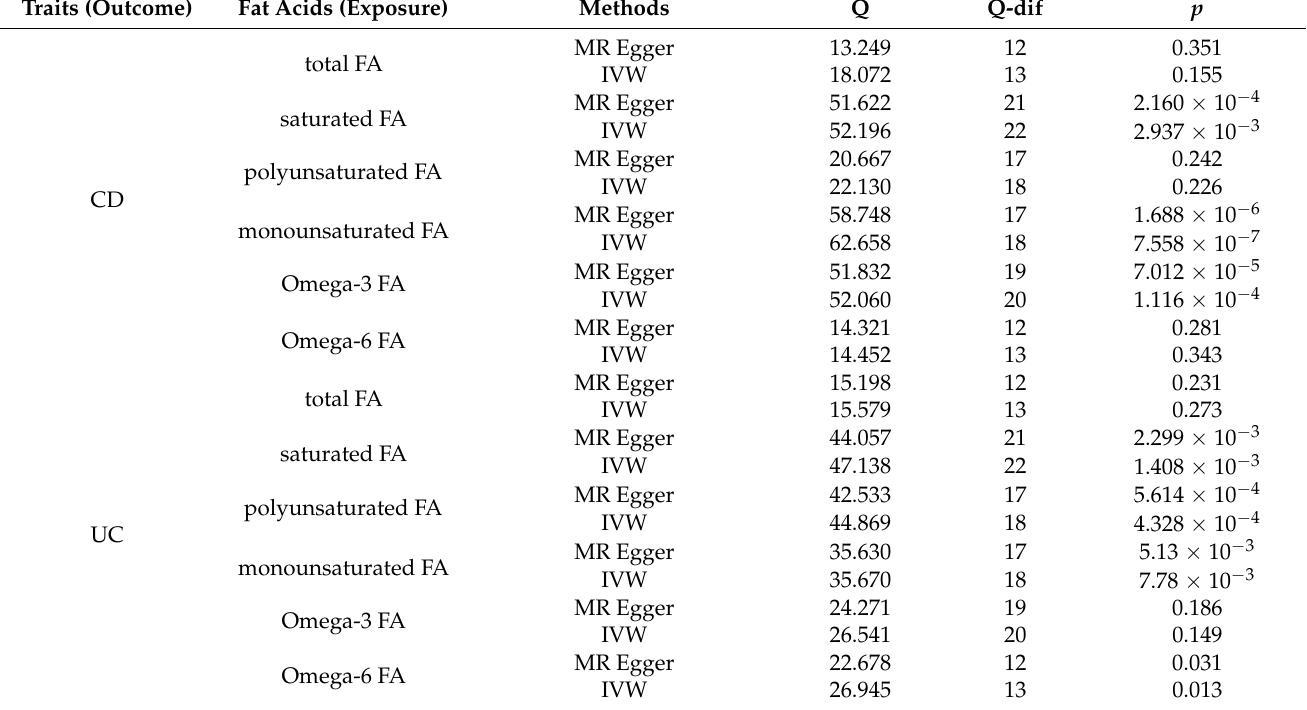
Table 4. The heterogeneity test of diverse fatty acids (FAs) genetic variants in inflammatory bowel disease (IBD) Genome-wide summary association study (GWAS)